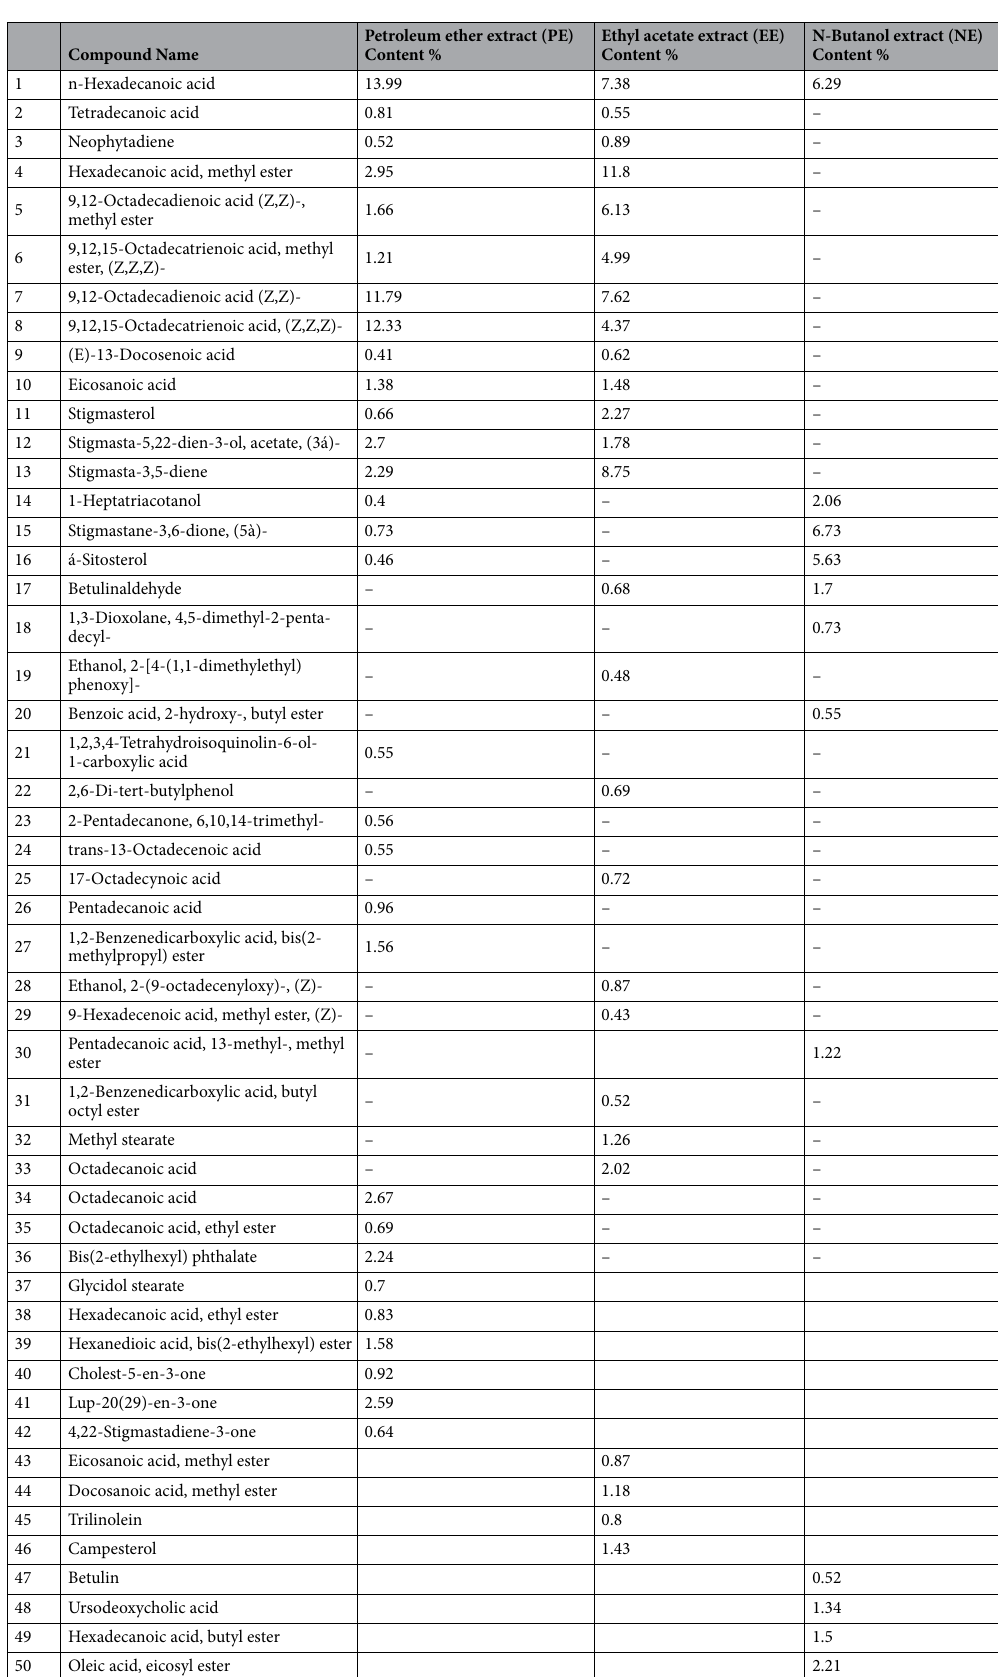
Table 2. Compounds in petroleum ether extracts that were identified by